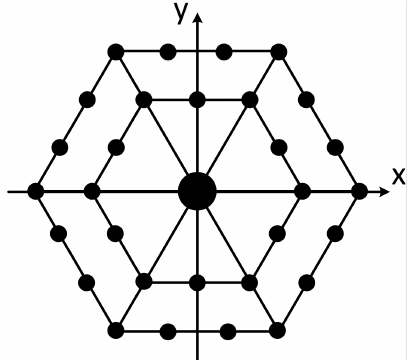
Figure 8. Positioning array element distribution.